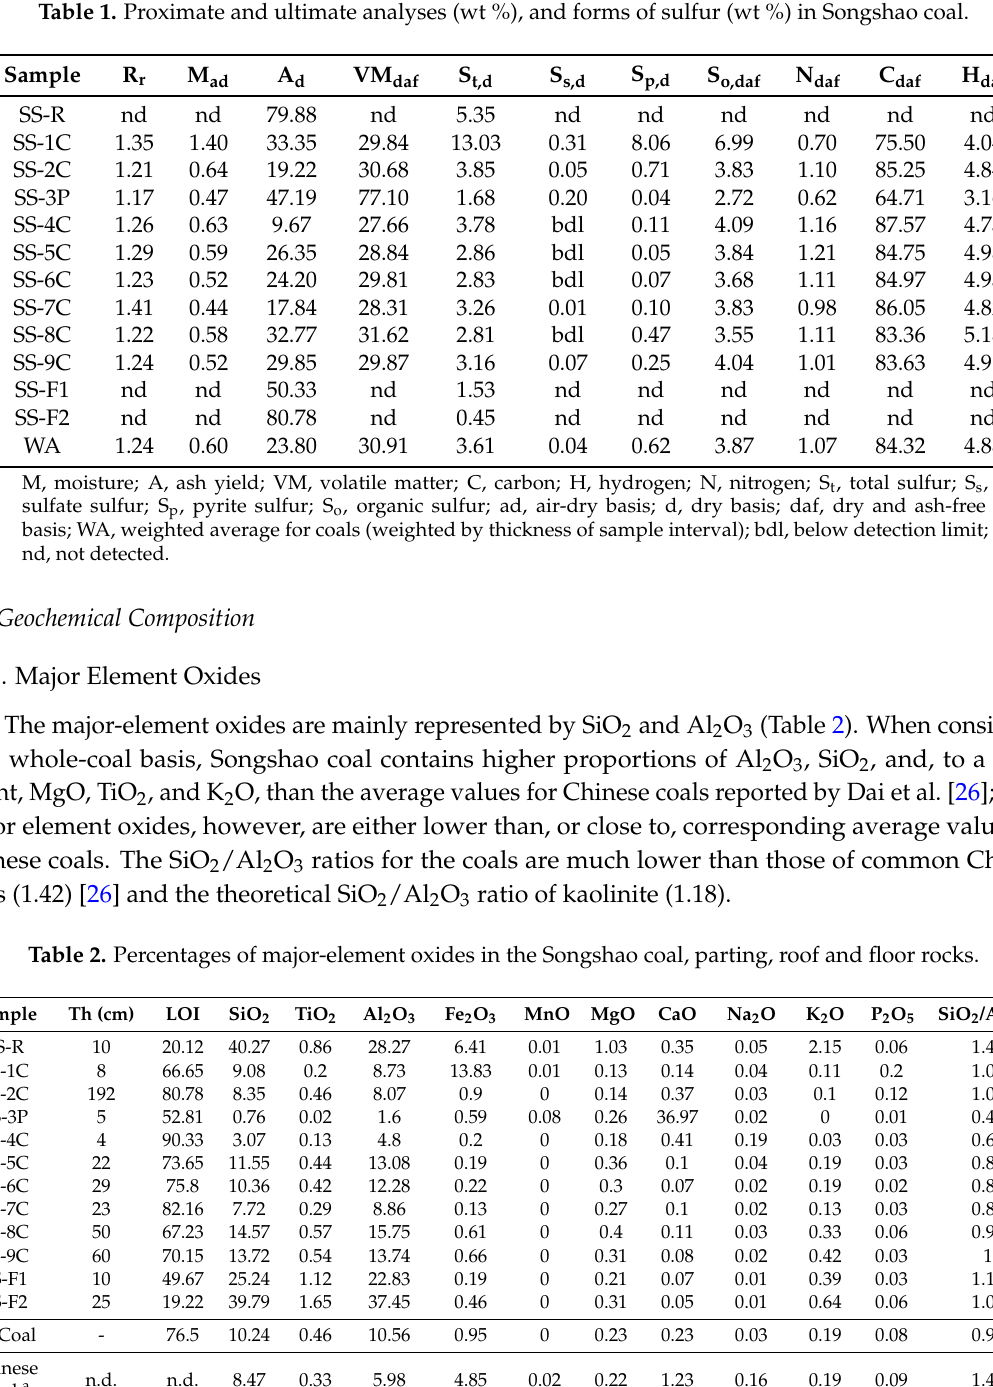
Table 1. Proximate and ultimate analyses (wt %), and forms of sulfur (wt %) in Songshao coal.